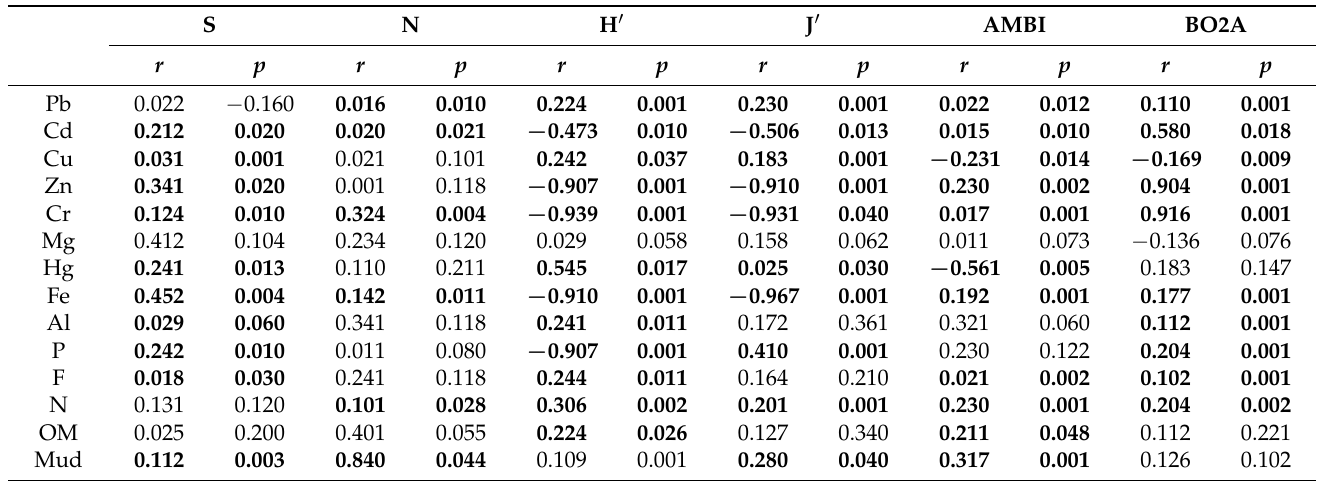
Table A4. Spearman’s rank correlation coefficients ( r ) and associated significance values ( p ) for relationships between sediment characteristics (chemical contamination, OM, sand and silt) and taxonomic richness (S), abundance (N), Shannon–Wiener diversity (H (cid:48) ), Pielou’s evenness (J (cid:48) ), AZTI marine biotic index (AMBI), and the benthic opportunistic annelids amphipods index (BO2A); significant correlations ( p < 0.05) are highlighted in bold